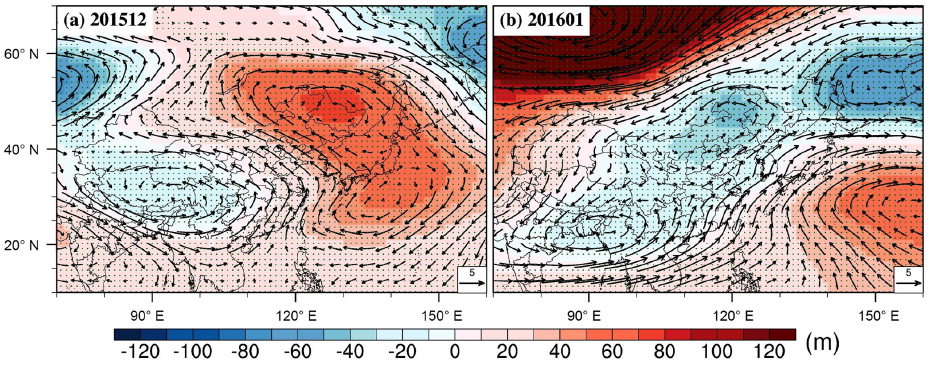
Figure 3. Anomaly of geopotential height and wind vector at 500hPa (unit: ms − 1 ) for December 2015 (a) and January 2016 (b) , with the anomaly relative to the respective month in 1987–2016. Stippled areas indicate geopotential height exceeding the 90th confidence interval. The 90th confidence interval was calculated for each grid based on a two-tailed t distribution method using the respective months’ data over the 30-year (1987–2016) period (i.e., geopotential height or wind vector at 500hPa).